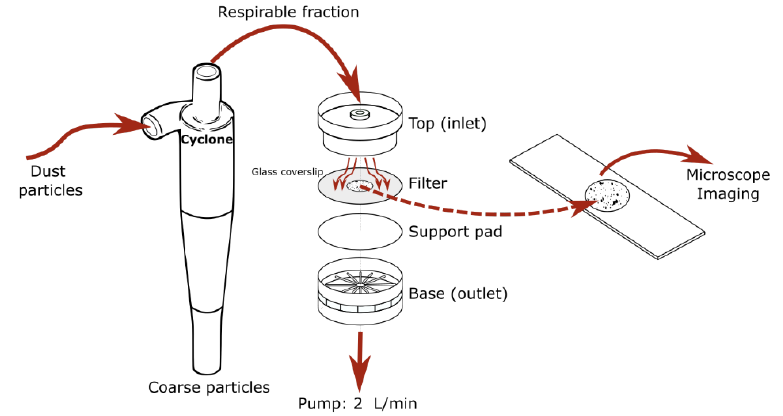
Figure 2. Sample preparation methods.